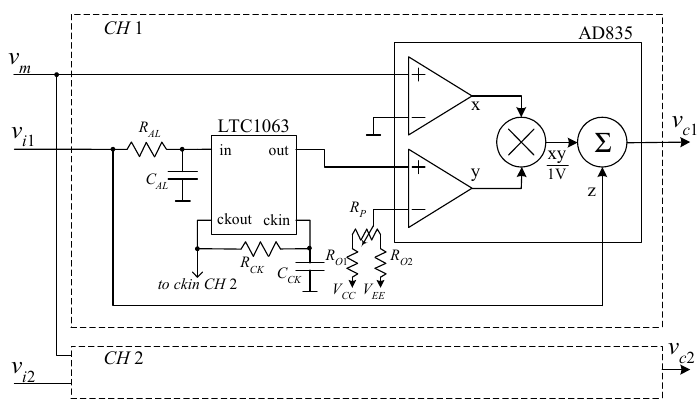
Figure 4. Schematic of the front-end board. R AL and C AL form an anti-aliasing low-pass filter for the 5th-order switched capacitor low-pass filter LTC1063. The corner frequency of the filter, which operates in self-clocking mode, is 1000 Hz. All the other operations required for the implementation of the approach we propose are performed by the analog multiplier AD835. The resistive networks R O 1 , R O 2 , and R P allow for nulling the DC offset.